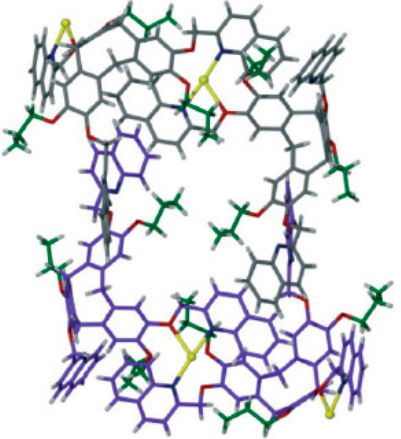
Figure 120. Structure of cationic lattice in [Ag 2 (tris(3-pyamino)CTG) 2 (MeCN) 2 ] + cation in {[Ag 2 (tris(2-quinamino)CTG-Pr) 2 ][3,3’-Co(1,2-C 2 B 9 H 11 ) 2 ] 2· 1.5(MeNO 2 )} n . Reproduced from reference [125] with permission from The Royal Society of Chemistry.